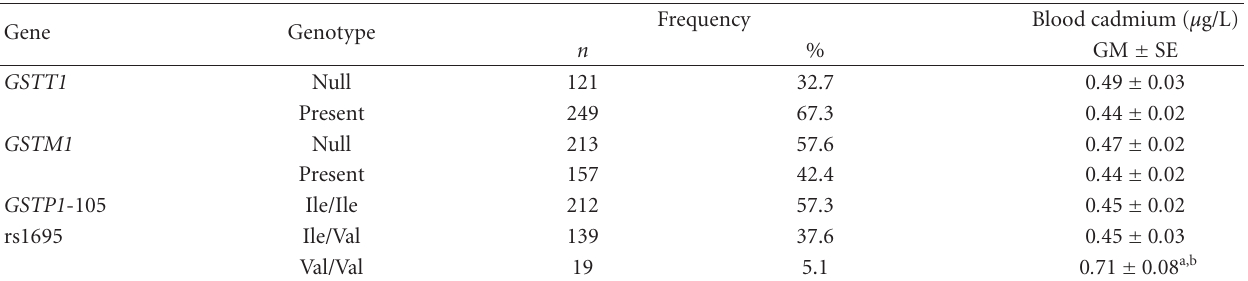
Table 2: Geometric means of blood cadmium concentrations in a nonoccupational exposed population categorized by di ff erent genotype.